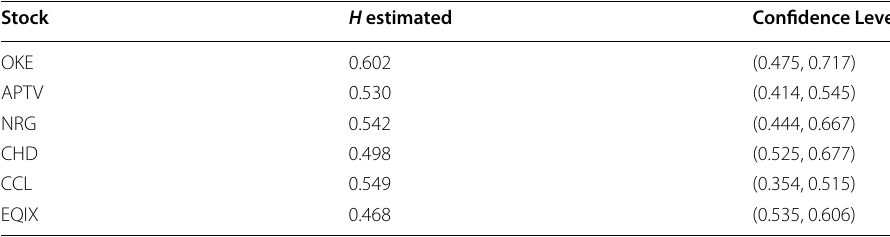
Table 10 Examples of the confidence intervals, at a 94.15% confidence level, for the estimated H s with the TA method for several stocks of the S &P500 index using 1024 trading days